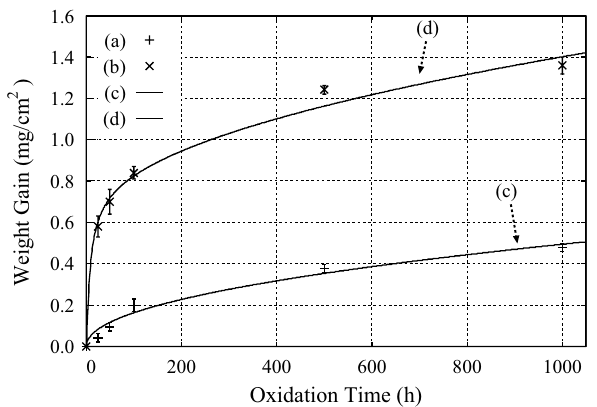
600 ◦ C and ( b ) at = 2.40 10 − 2 (mg/cm 2 ) and A 4.06 at = × =